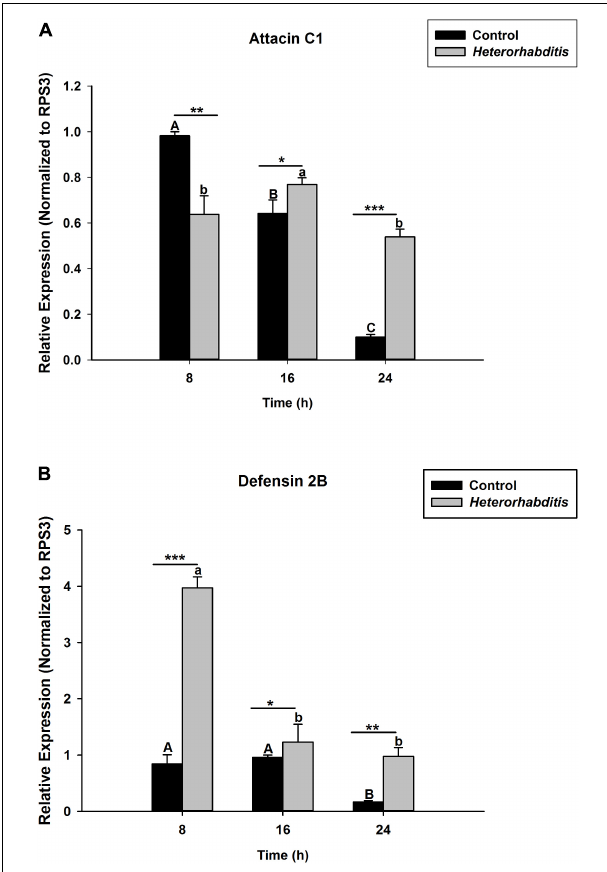
FIGURE 2 | Transcription of antimicrobial peptide (AMP) genes in O. nipae larvae infected with H . bacteriophora AMP transcription levels were shown for (A) Attacin C1, (B) Defensin 2B. Error bars labeled with different letters are significantly different (one-way ANOVA followed by LSD test, p < 0.05). ∗∗∗ P < 0.0001; ∗∗ P < 0.001; ∗ P < 0.01) indicates significantly different levels between the control and H . bacteriophora treatments at the indicated time period; while “ns” indicates no significant difference.